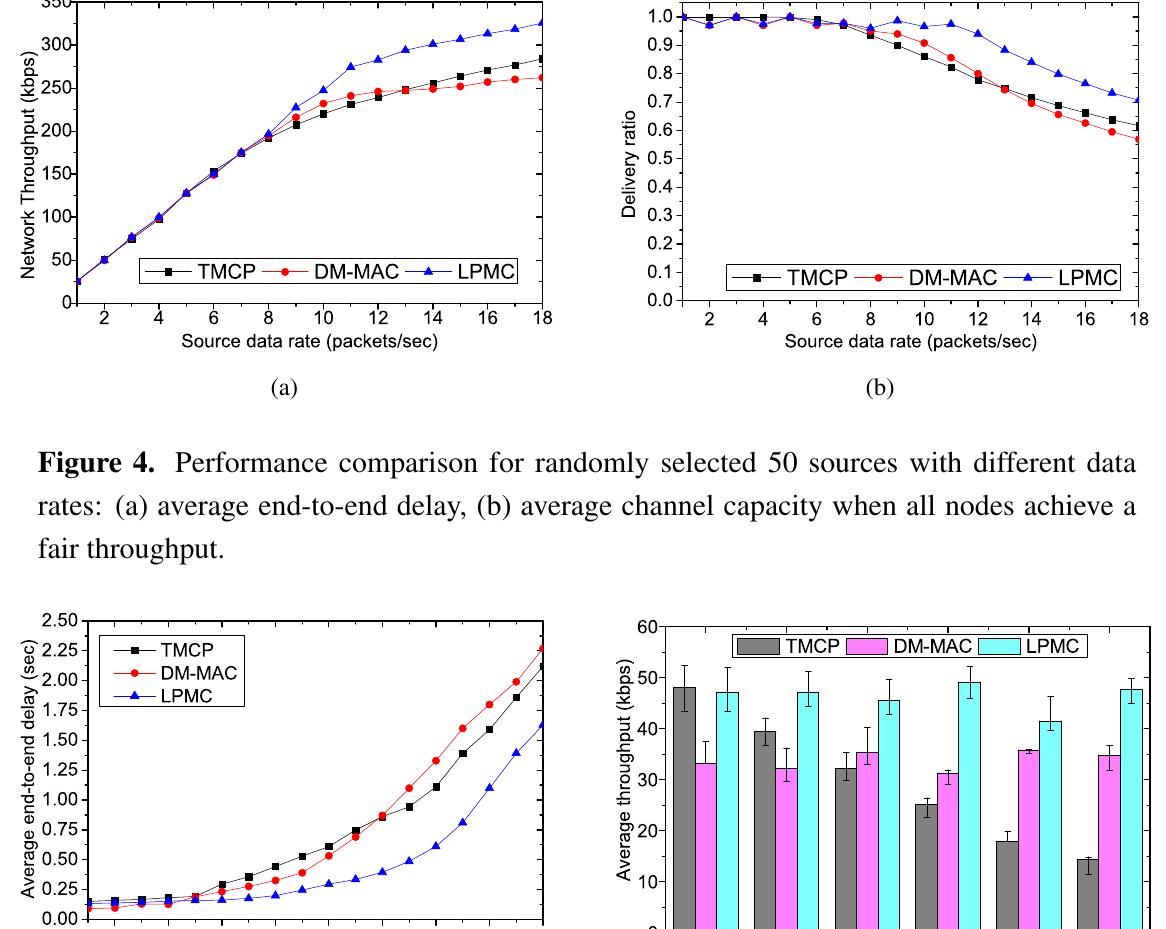
Figure 3. Performance comparison for randomly selected 50 sources with different data rates: (a) network throughput, (b) delivery ratio.